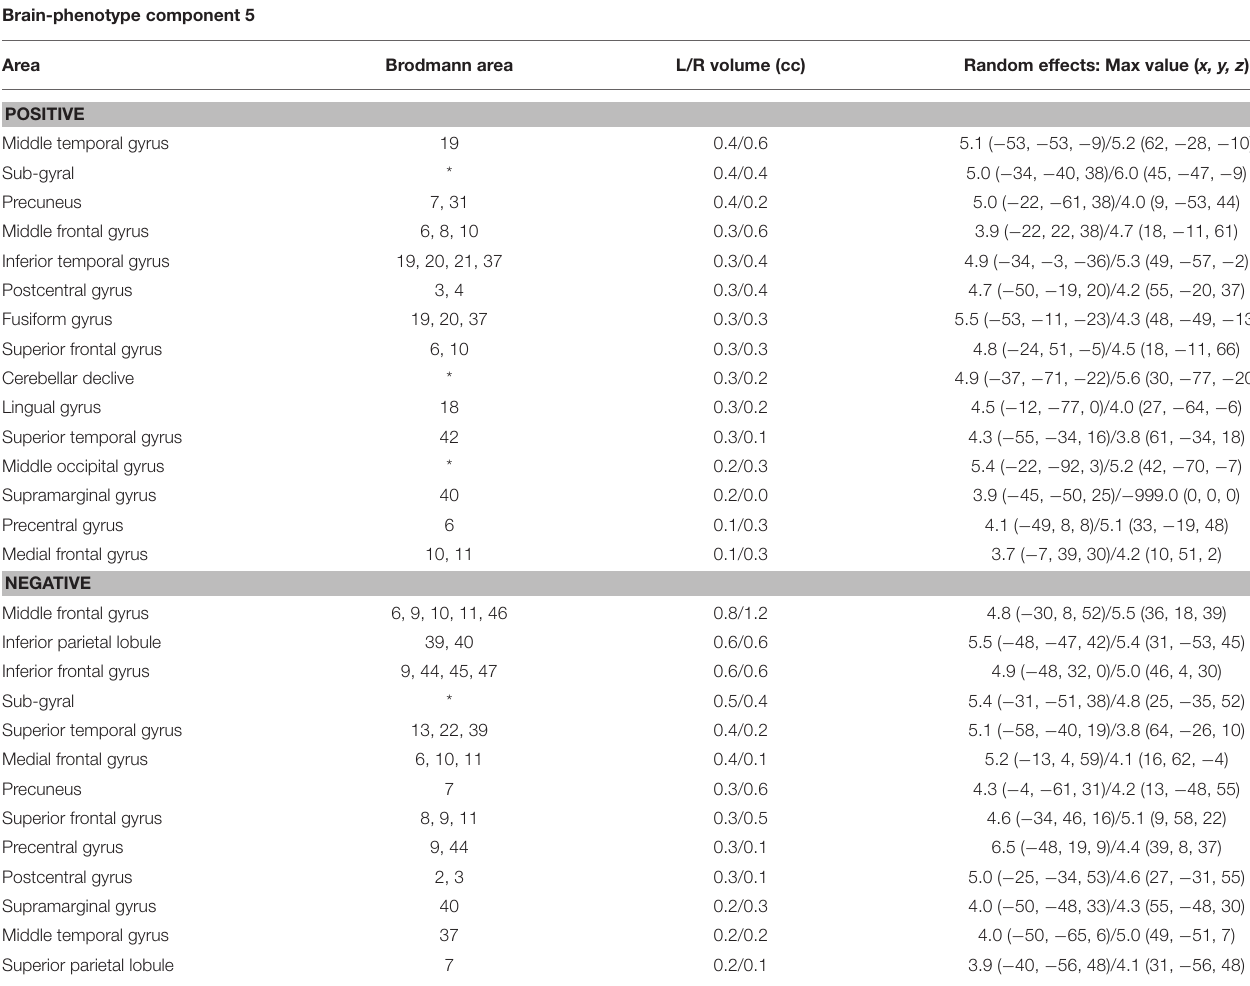
TABLE 5 | Significant brain regions associated with gray matter density and SNP-based ePRS-5-HTT data on MRI component 5 by Parallel ICA. Brain-phenotype component